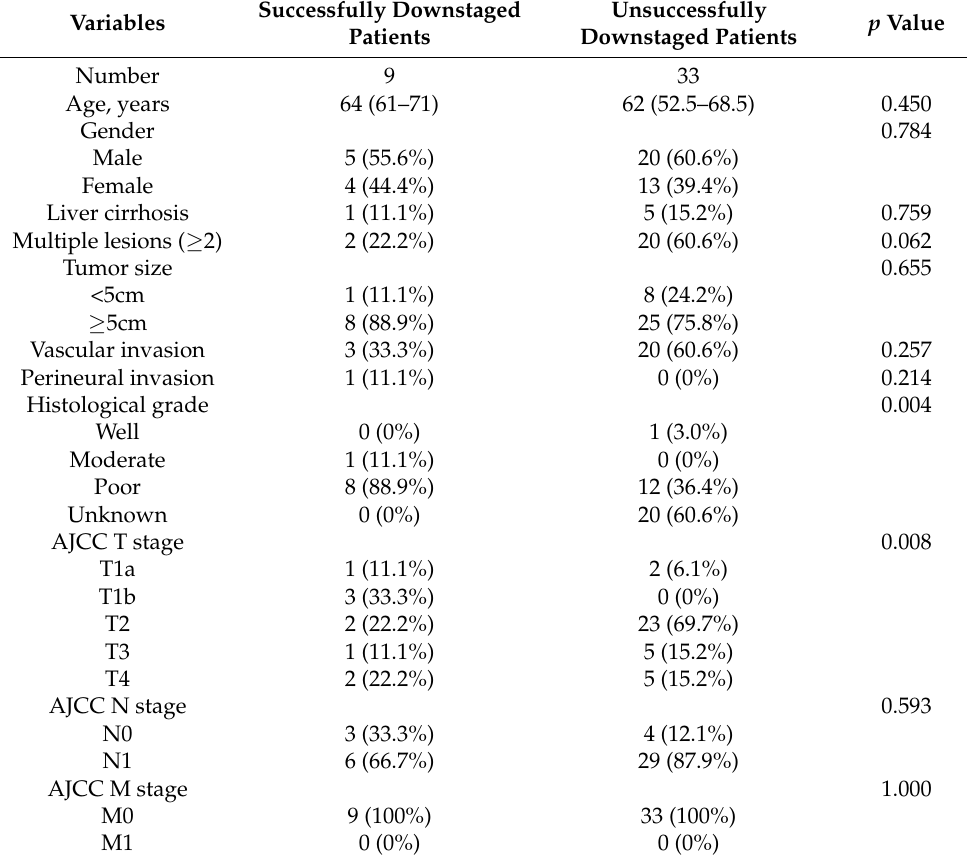
Table 1. Demographic and clinical data of patients receiving conversion therapy.